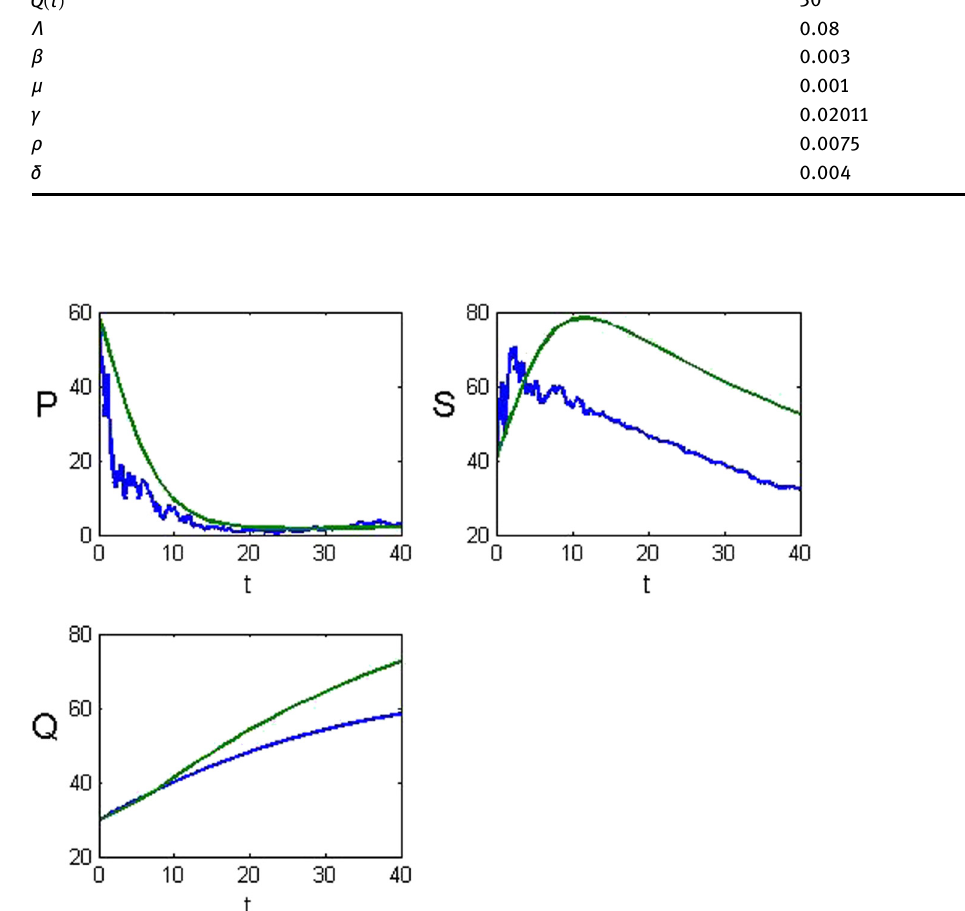
Figure 1: Graphs of ( P ) potential smokers using a deterministic method ( green line ) and from a stochastic solution ( blue lines ) , ( S ) chain smokers using a deterministic method ( green line ) and from a stochastic solution ( blue lines ) and ( Q ) quit smokers using a deterministic method ( green line ) and from a stochastic solution ( blue lines ) . The stability of stochastic graphs shows best expression than deterministic